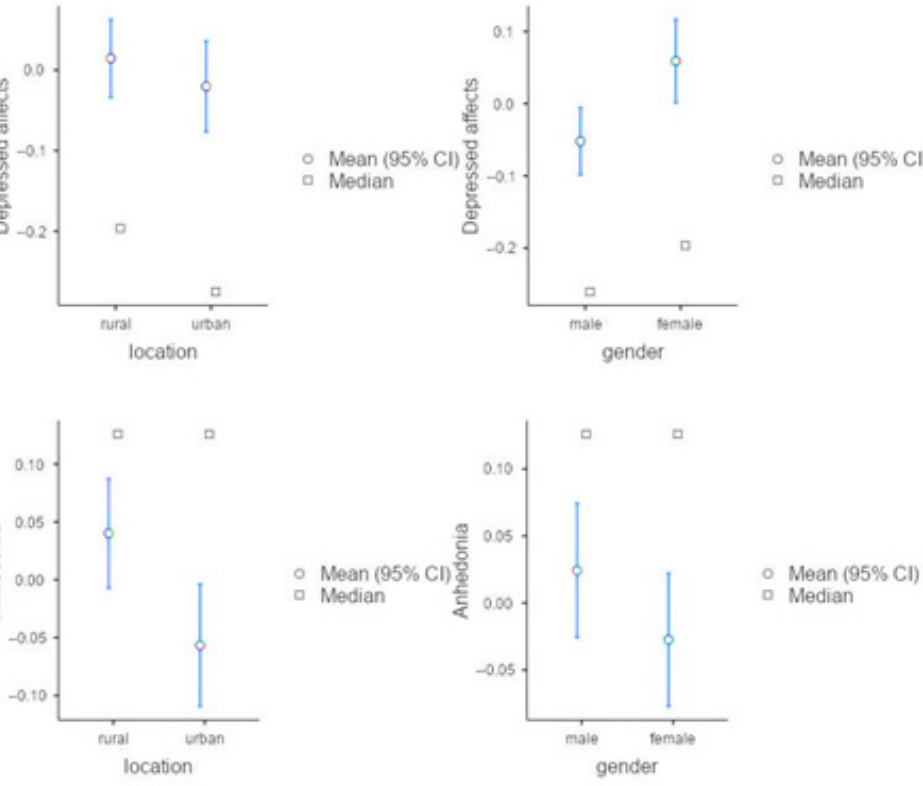
Figure 1. Descriptive Plots of T-tests to Compare the Group Differences in Depressed Affect and Anhedonia among the CFPS-2018 Participants ( n =